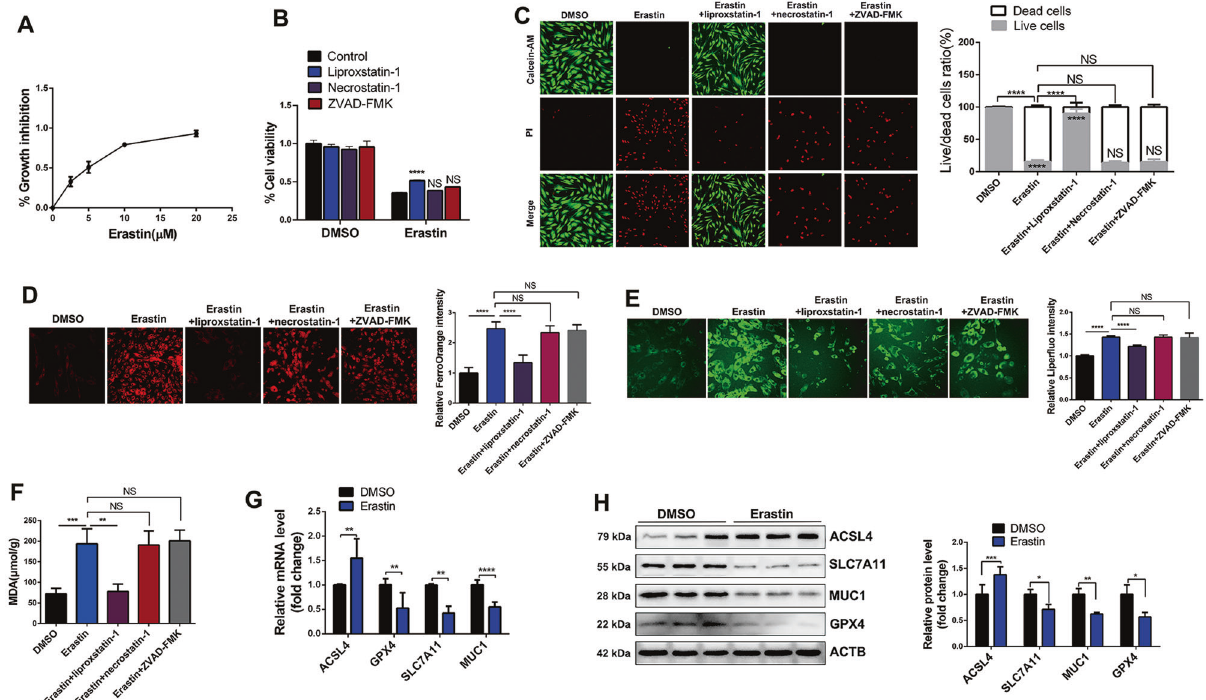
Fig. 2 Erastin triggers ferroptosis in endometriosis. A EESCs were treated with the indicated concentrations of erastin (2.5, 5, 10, and 20 µM) in 96-well plates for 24 h. CCK-8 assay was used to detect cell viability. B – F EESCs were treated with erastin (10 μ M) with or without the indicated inhibitors (liproxstatin-1, 1 μ M; necrostatin-1, 10 µM; ZVAD-FMK, 10 μ M) for 24 h. B Cell viability was detected by a CCK-8 assay. C Living and dead cells were stained with a Calcein-AM/PI Double Stain Kit. Green represents viable cells, red represents dead cells, and the scale bar = 100 μ m. Cell viability was expressed as the percentage of viable cells. D Cells were treated with 1 μ M FerroOrange to detect intracellular Fe 2 + . Intracellular Fe 2 + visualized by FerroOrange (magni fi cation, ×200). E Cells were treated with 5 µM Liper fl uo to detect lipid peroxidation. Ferroptosis marker visualized by Liper fl uo (magni fi cation, ×200). F MDA levels were assayed after the indicated treatment. G qRT-PCR was used to detect the mRNA levels of ACSL4, GPX4, SLC7A11, and MUC1 in EESCs after erastin (10 µM) or DMSO treatment for 24 h. H Western blot analysis was used to detect the protein levels of ACSL4, GPX4, SLC7A11, and MUC1 in EESCs after erastin (10 µM) or DMSO treatment for 24 h. All data are shown as the mean ± SD of three independent experiments (NS is nonsigni fi cant, * P < 0.05, ** P < 0.01, *** P < 0.001, **** P < 0.0001). Statistical signi fi cance was calculated using Student ’ s t test. EESC ectopic endometrial stromal cell, MDA malondialdehyde, ZVAD-FMK benzyloxycarbonyl-Val-Ala-Asp (OMe)- fl